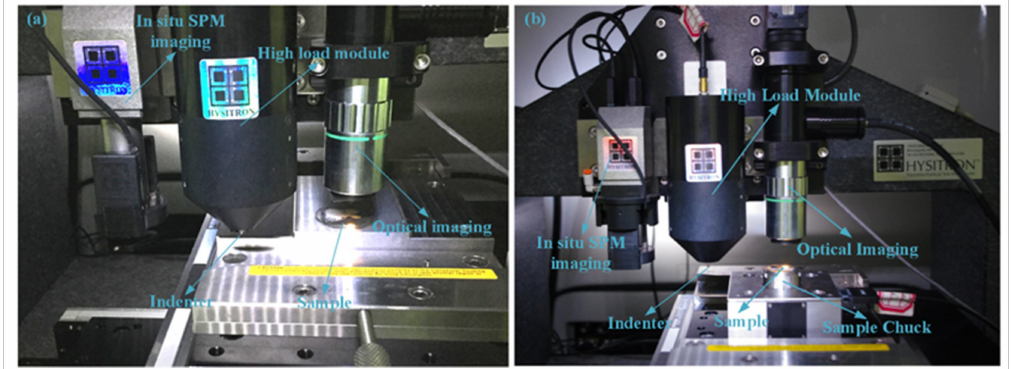
Figure 5. Photographs of the Ti 950 Triboindenter. ( a ) The apparatus used for the indentation tests. ( b ) The apparatus used for the scratch